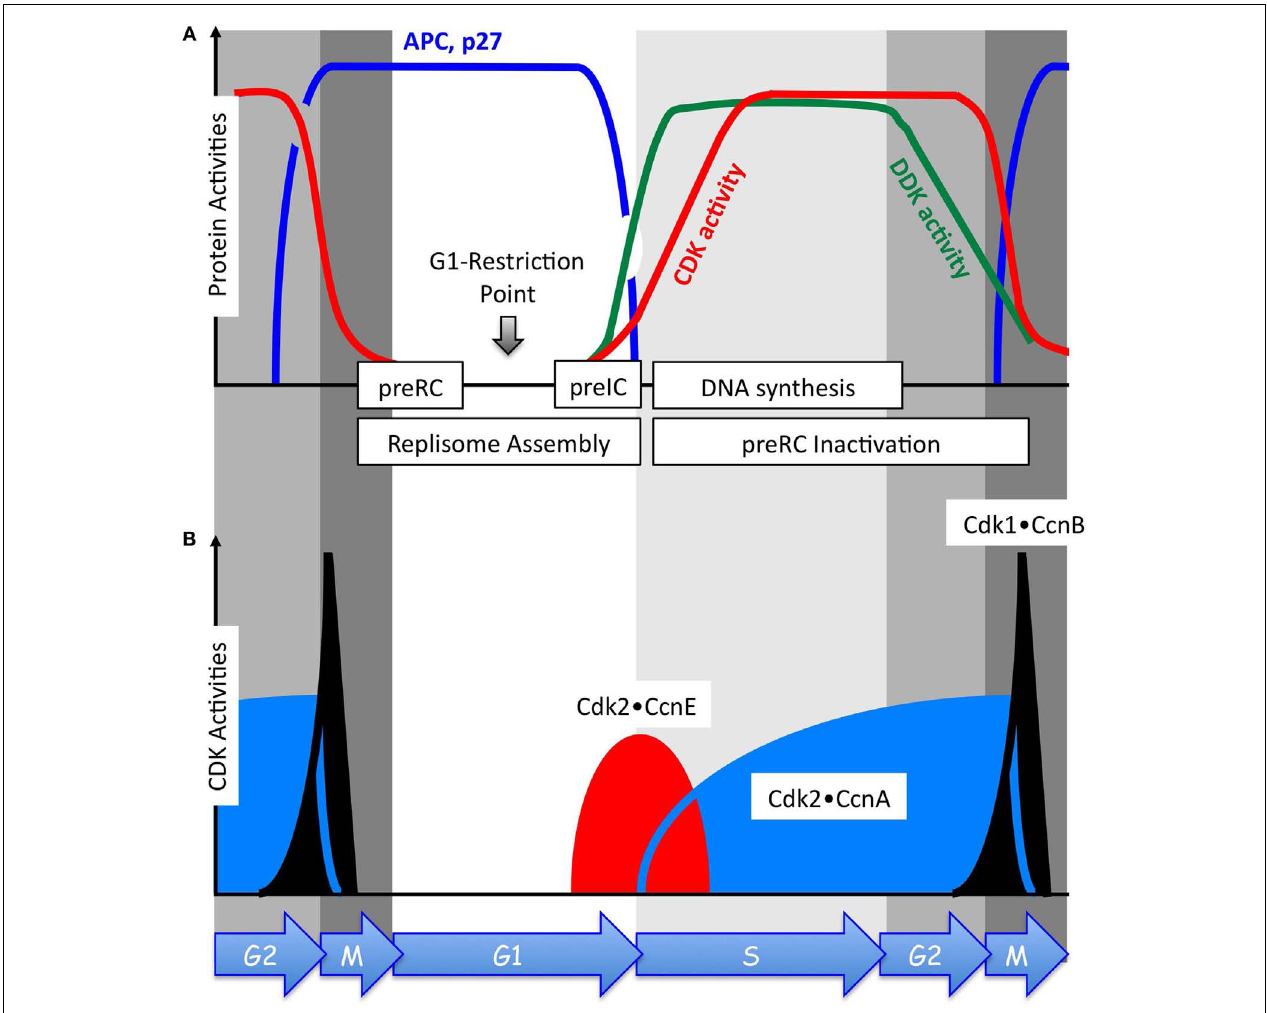
Cyclins are targeted for ubiquitin-dependent degradation by a series of feedback loops involving CDKs and ubiquitin ligases whose activities are themselves cell cycle dependent ( Figure 3 ). As cells exit metaphase, the APC targets CcnA and CcnB for ubiquitin-dependent degradation.Therefore, the combined effects of the APC, p27, and the protein kinaseWee1 (not shown) inactivate Cdk1, Cdk2, Cdk4, and Cdk6. PreRC assembly ( Figure 5 , top panel) occurs only in the absence of CDK activity, the period encompassed by anaphase, telophase, and G1 phase (Figure 2). PreIC assembly ( Figure 5 ) begins with the appearance of DDK and CDK activities in late G1 phase (A) . PreRC components are inactivated during S and G2 phases in order to prevent DNA re-replication ( Figure 6 ).The G1-Restriction Point occurs after preRC assembly and before preIC assembly (Wu and Gilbert,